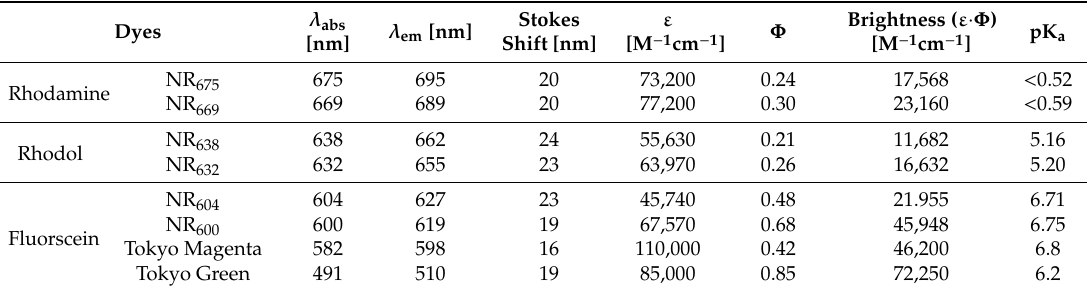
Table 1. Summary of spectroscopic data of the newly synthesized dyes, including previously reported values for Tokyo Magenta [298] and Tokyo Green [98] for